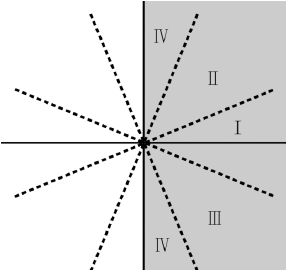
Figure 3. schematic of the intervals of statistical directions Since the tangent values of the complementary angles are the same, the results of arc tangent are directly used as the data to be statistical analyzed regardless of the unit conversion of the angle data calculated by the formula (3). Count the number of squiggles in each direction interval, and then compute the judgment value R max through dividing the maximum number with most squiggles by the total number. At last, whether there exists deformation or not is determined by comparing R max with the threshold T jud . The pre-set T jud , with the data range (0.25, 1), directly influences the judging results. The smaller the threshold T jud is, the easier the deformation is to be